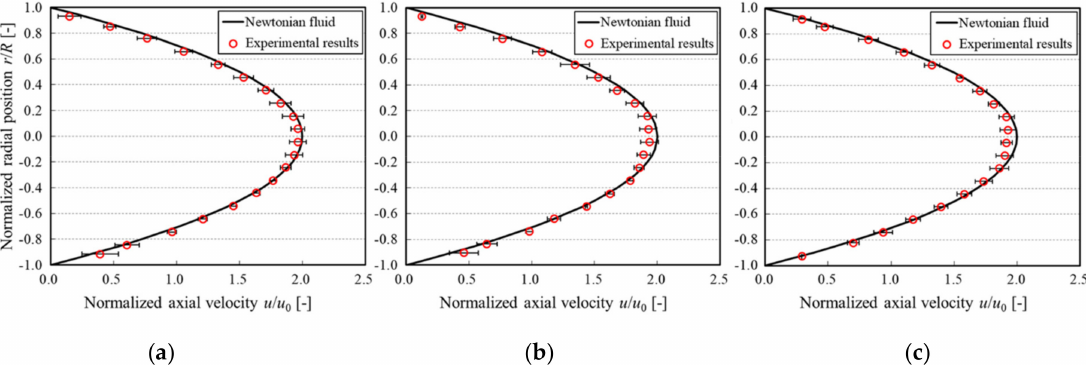
Figure 5. Normalized axial velocity profiles. The red plots and error bars are the mean ± 1 SD, and the black solid line is the velocity profile of Newtonian fluid ( n = 1) for comparison. ( a ) Re p = 2.9 × 10 − 4 , ( b ) Re p = 5.8 × 10 − 4 , and ( c ) Re p = 1.2 × 10 − 3